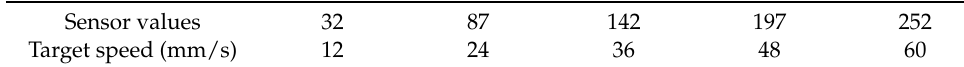
Table 9. Correspondence between sensor value and target speed.